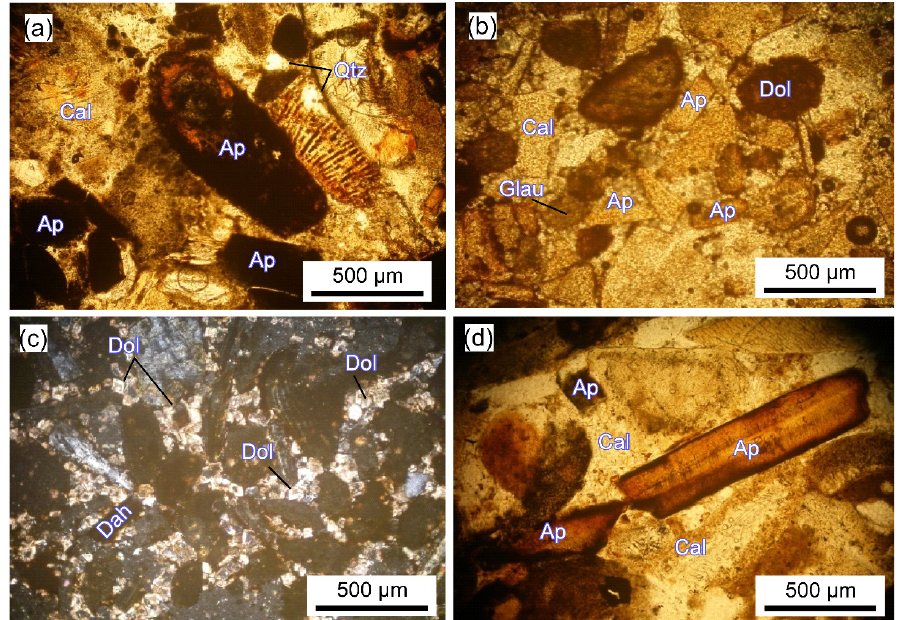
Figure 3. Photomicrographs showing ( a ) Apatite (Ap) grains with bone fragments embedded in calcite (Cal) and silica (Qtz) matrix; ( b ) Apatite grains elongated to surrounded with bone fragments and shark teeth, glauconite (Gaul), and dolomite (Dol) embedded in carbonate cement; ( c ) Dahlite (Dah) and dolomite grains with bone fragments embedded in carbonate cement; and ( d ) Elongated apatite (Ap) grains with bone fragments embedded in carbonate cement.